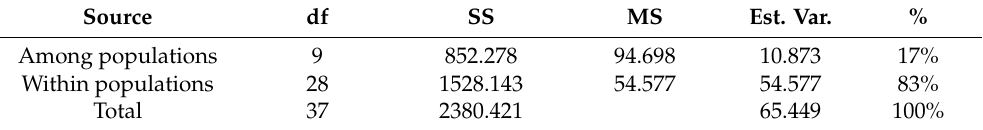
Table A4. AMOVA results among populations and within populations.